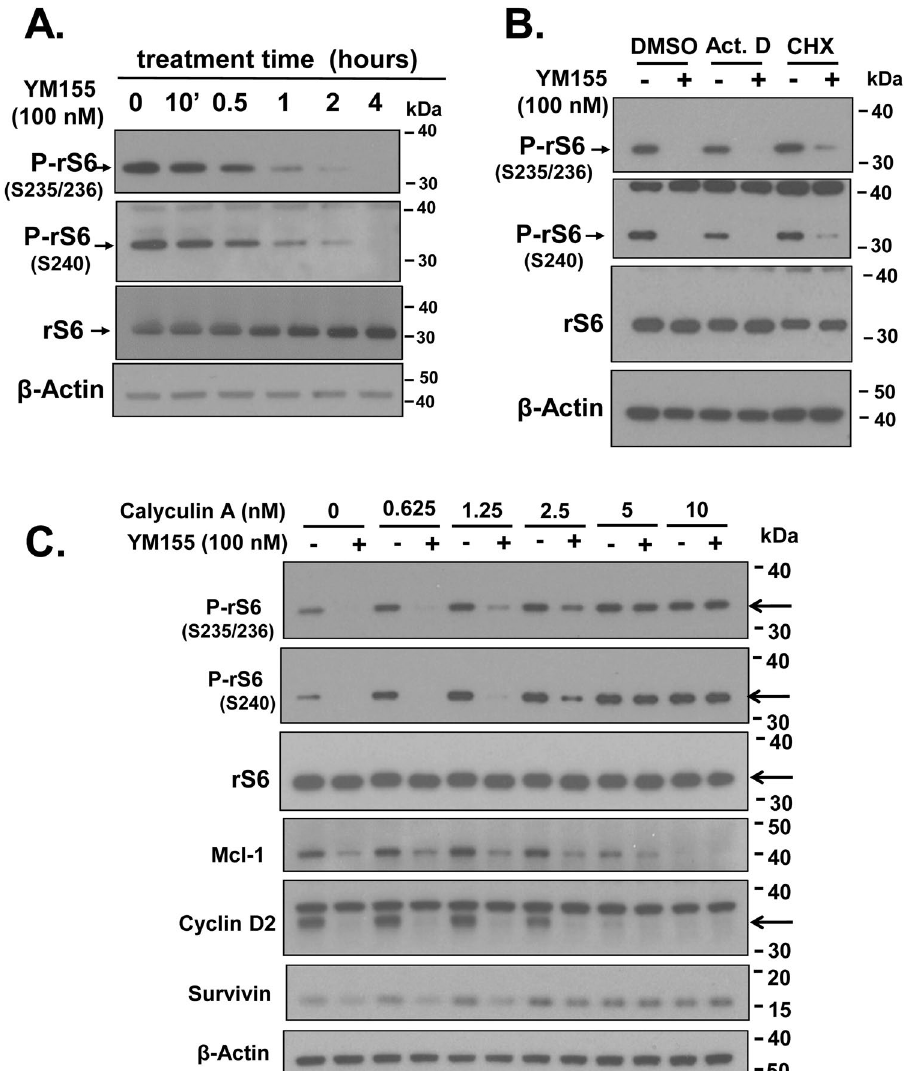
Figure 5. Effect of YM155 on phosphorylation of the ribosomal protein S6. ( A ) Temporal changes in levels of phosphorylated (S235/236) ribosomal protein S6 versus that of total ribosomal protein S6 as assessed by Western blotting. ( B ) Effect of YM155 (4 h) on the suppression of P-rS6(S235/236), P-rS6(S240) in PC-3 cells pre-treated for 30 min with Act D (2 μ g/ml), CHX (2 μ g/ml) or DMSO vehicle, as assayed by Western blot. ( C ) Effect of YM155 (4 h) on the suppression of Survivin, Mcl-1, Cyclin D2, P-rS6(235/236) and P-S6(S240) in PC-3 cells pre-treated for 30 min with rapamycin (Rap), as assayed by Western blot. Effect of various doses of Calyculin A (30 min pre-treatment) on the suppression of Survivin, Mcl-1, Cyclin D2 and P-S6(S240) by YM155 (100 nM, 4 h) in PC-3 cells, as assayed by Western blot. Unless indicated on the figure, each group of blots represents data obtained from a single gel and experiment. Results shown are representative of 2 to 3 independent